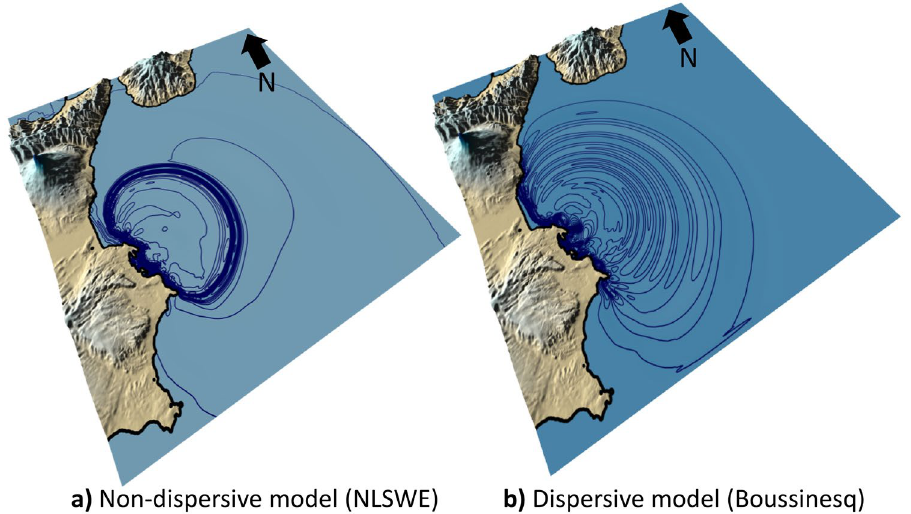
Figure 10. Dispersion effects for the tsunami propagation in a DTS scenario, 10 min after the start of simulation; a) non-dispersive model based on nonlinear shallow water equations (NLSWE); b) dispersive model based on Boussinesq equation. The maps were obtained by co-authors through QGIS—software (version 3.14.16); https:// www. qgis. org/ it/ site/, license Creative Commons. Attribution-Share Alike 3.0 licence (CC BY-SA) integrated with ESRI World Imagery.